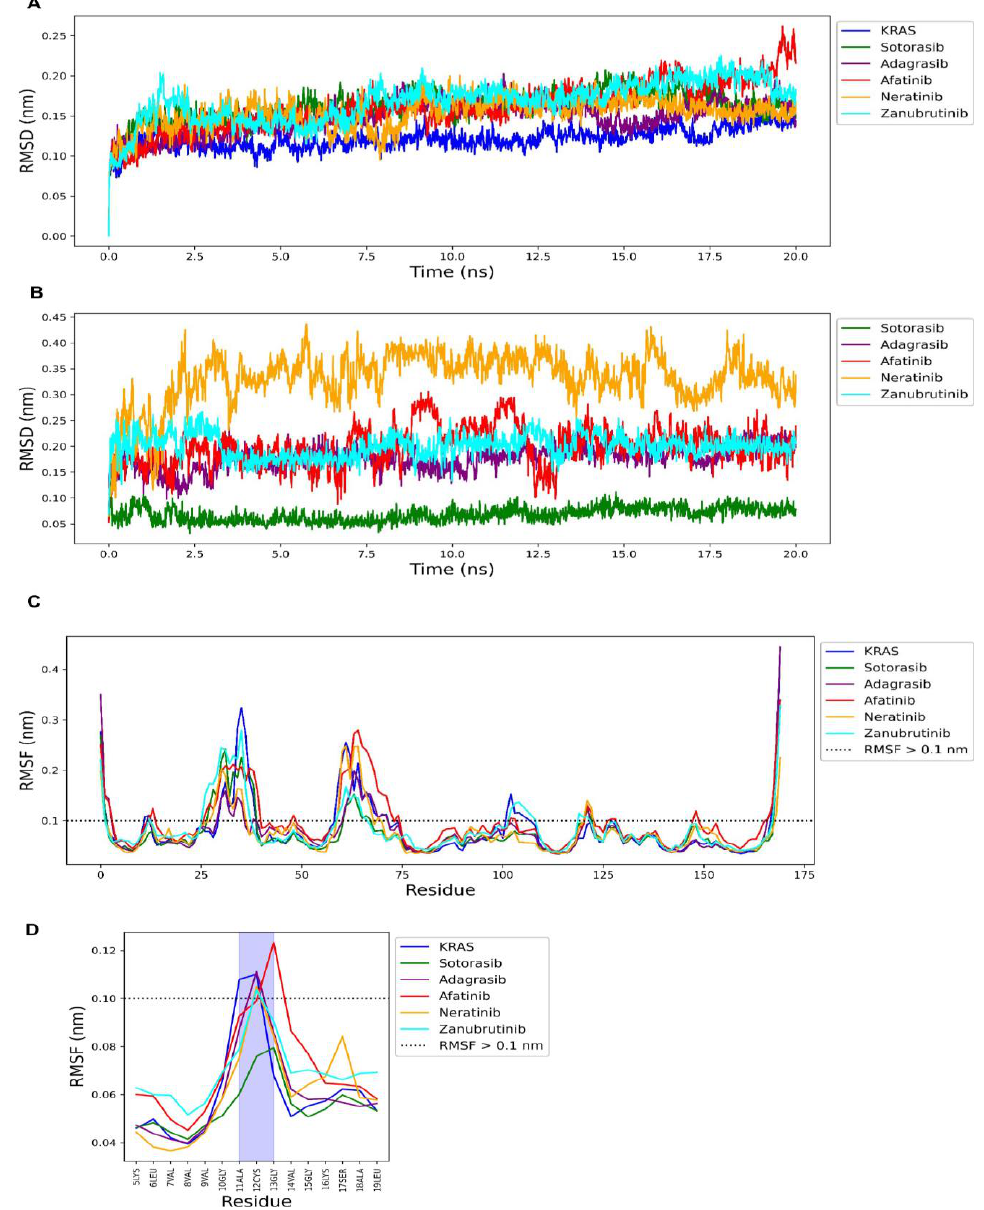
Figure 9. Molecular dynamics simulations of sotorasib, adagrasib, afatinib, neratinib, and zanubrutinib. ( A ) Time series of the distance of c-alpha atoms of KRAS G12C protein when interacting with predicted drugs; and ( B ) time series of the distance of predicted drugs when interacting with the KRAS G12C protein. ( C ) Amino acid distance fluctuation when interacting with predicted drugs; and ( D ) amino acid distance fluctuation at cysteine 12. The KRAS protein, sotorasib, adagrasib, afatinib, neratinib, and zanubrutinib are represented in blue, green, purple, red, orange, and cyan colors, respectively.